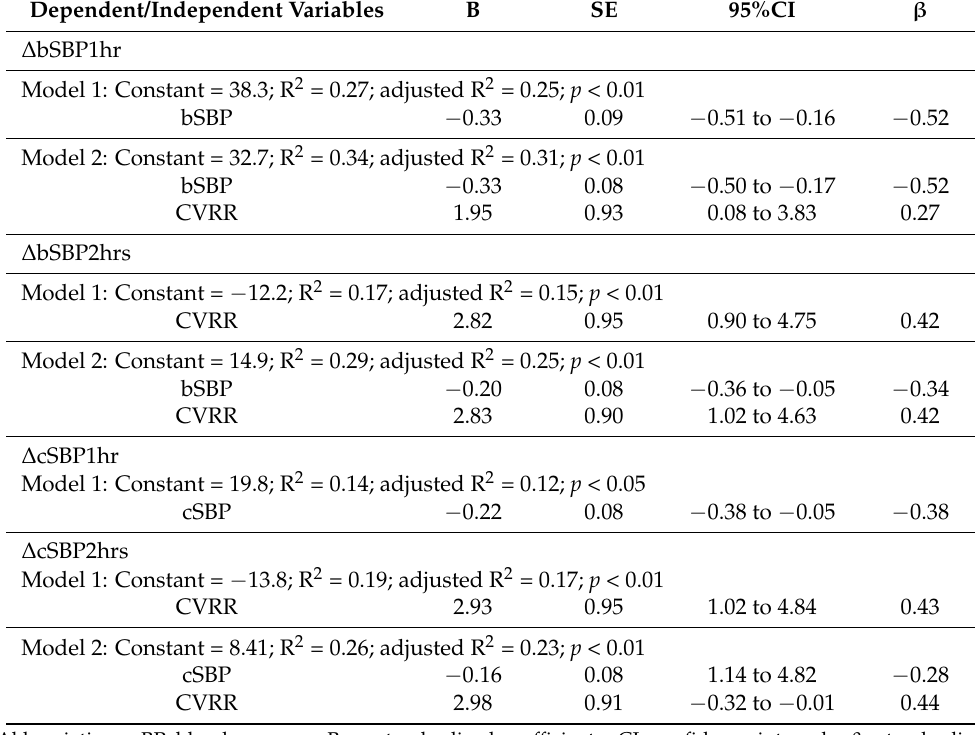
Table 3. Multiple linear regression analysis for predicting the magnitude of postprandial blood pressure